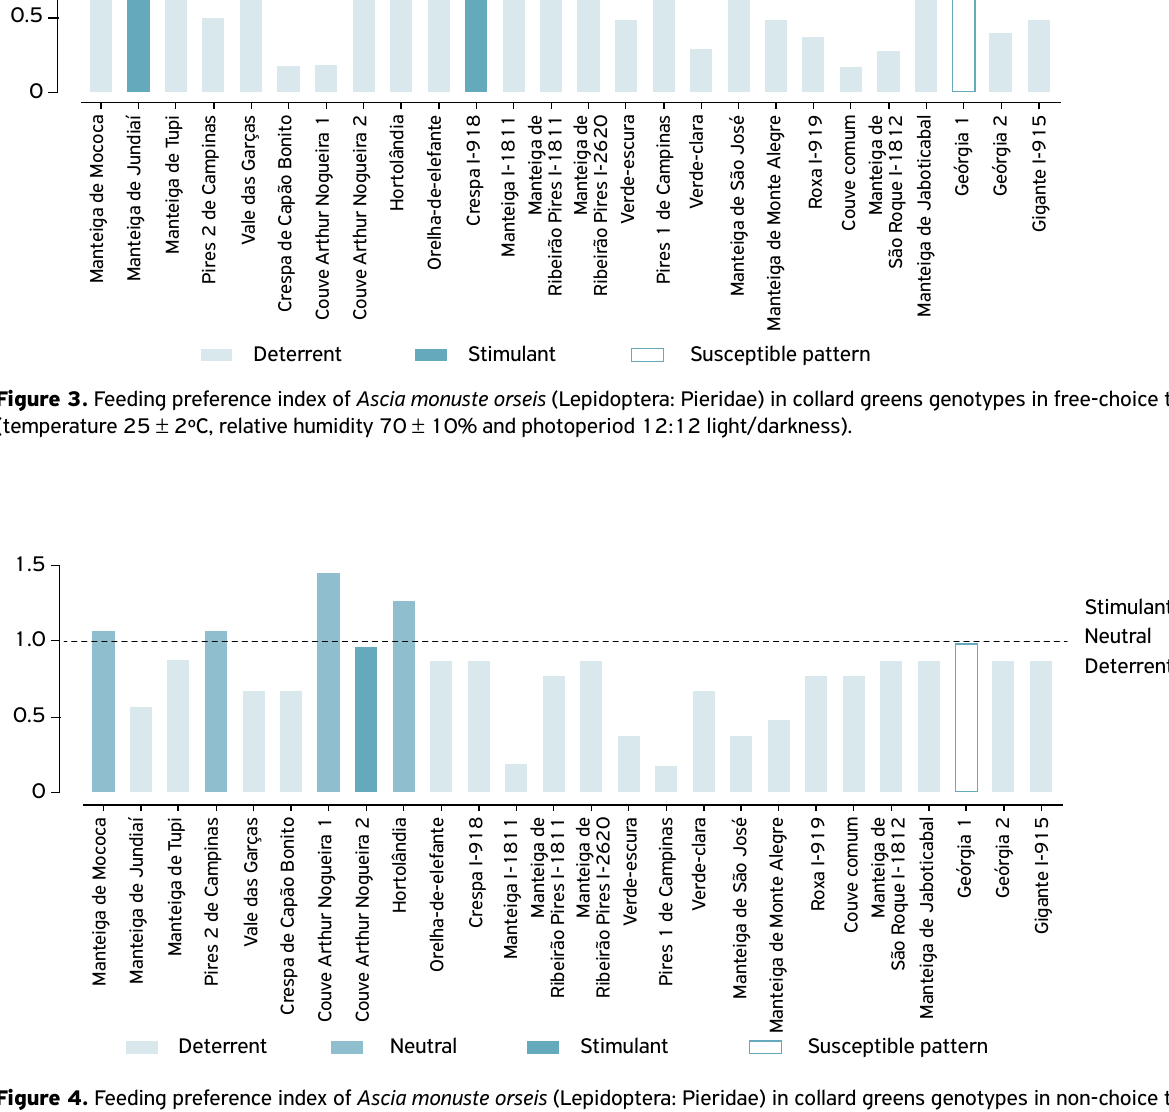
Figure 4. Feeding preference index of Ascia monuste orseis (Lepidoptera: Pieridae) in collard greens genotypes in non-choice test (temperature 25 ± 2ºC, relative humidity 70 ± 10% and photoperiod 12:12